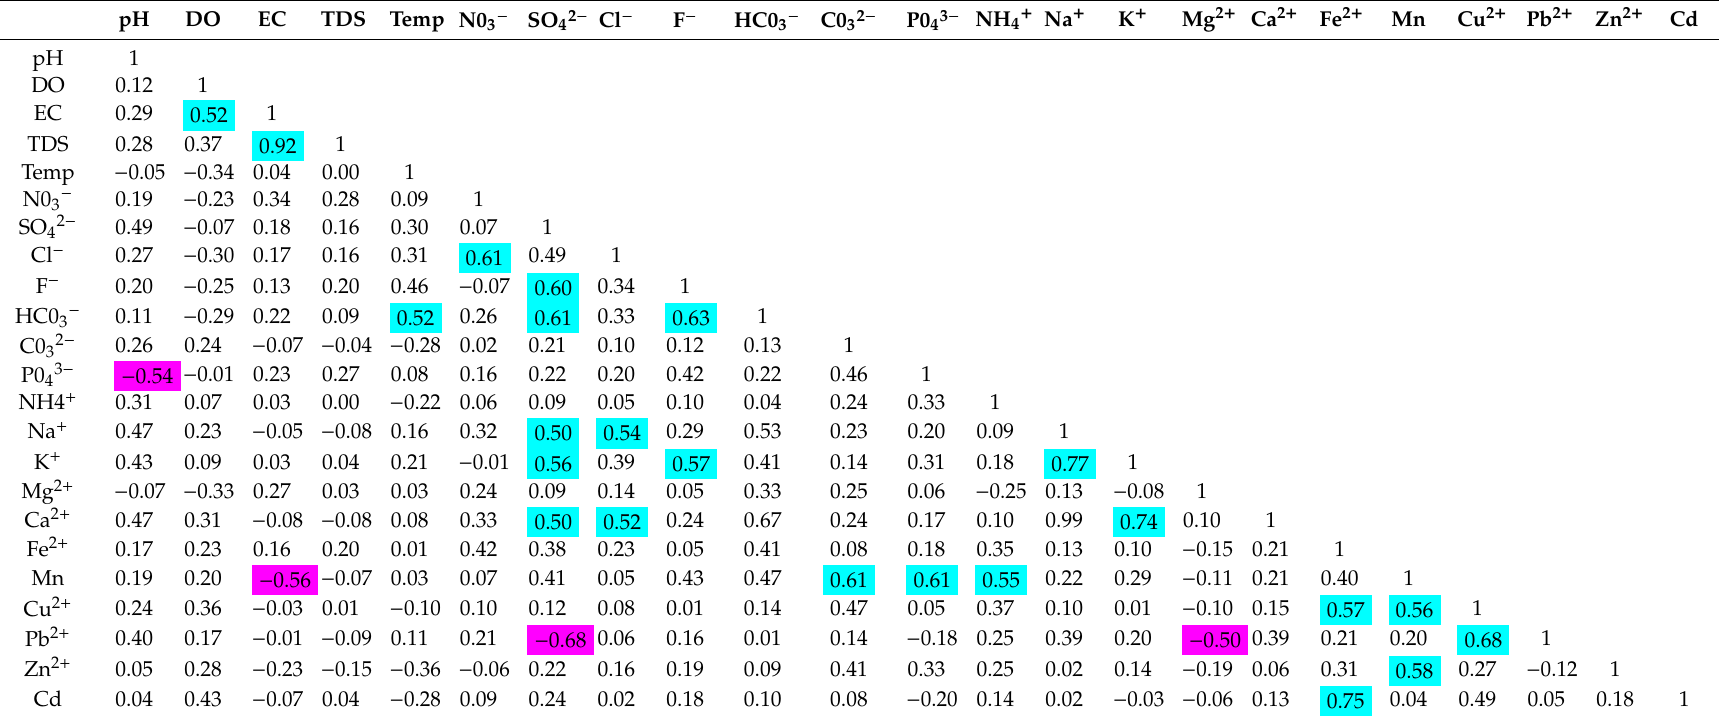
Table A3. Pearson correlation matrix of groundwater for the wet